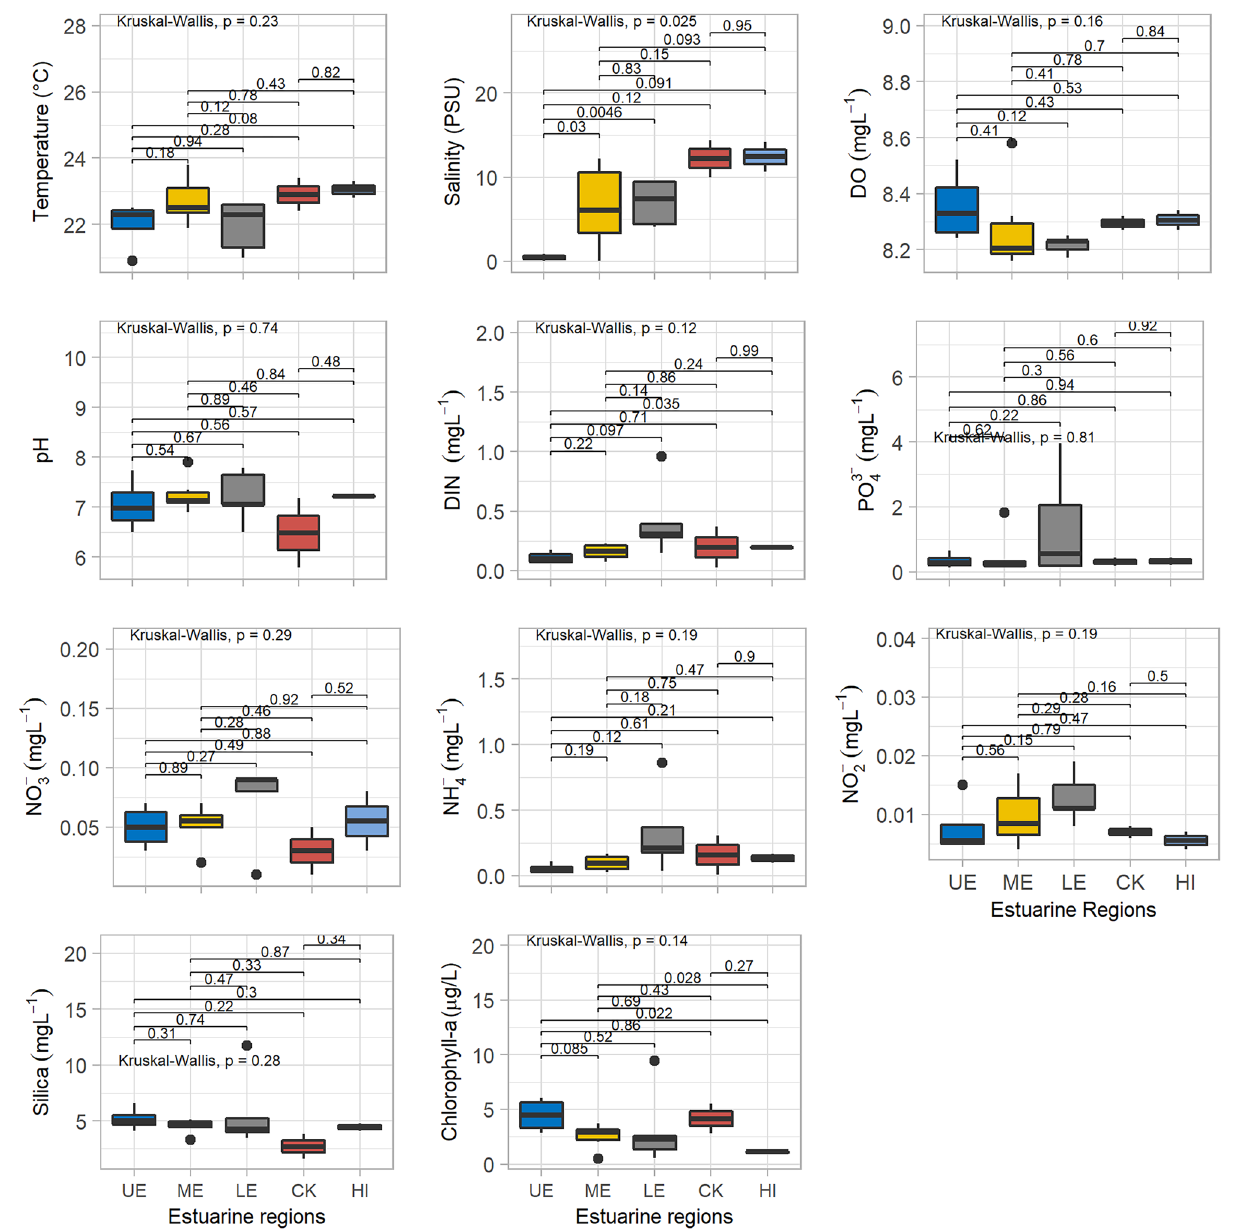
Figure 5. Spatial distributions of major hydro-chemical parameter, dissolved inorganic nutrients and chlorophyll-a in the lower Meghna River estuary during the dry season (UE = Upper estuary, ME = Middle estuary, LE = lower estuary, CK = Char Kukrimukri, HI = Hatiya Island). Note: the same for the Fig.